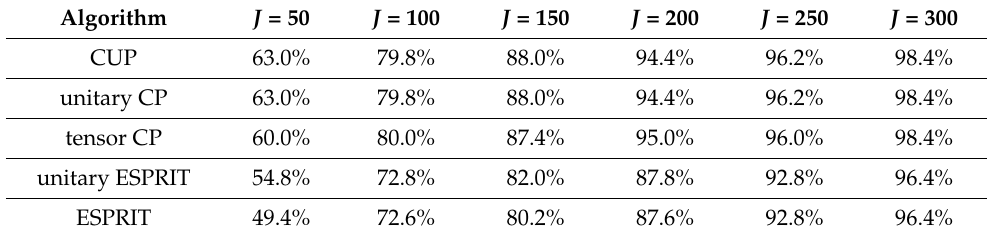
Figure 13. PSD of range estimation versus Snapshots. Table 10. PSD of range estimation versus